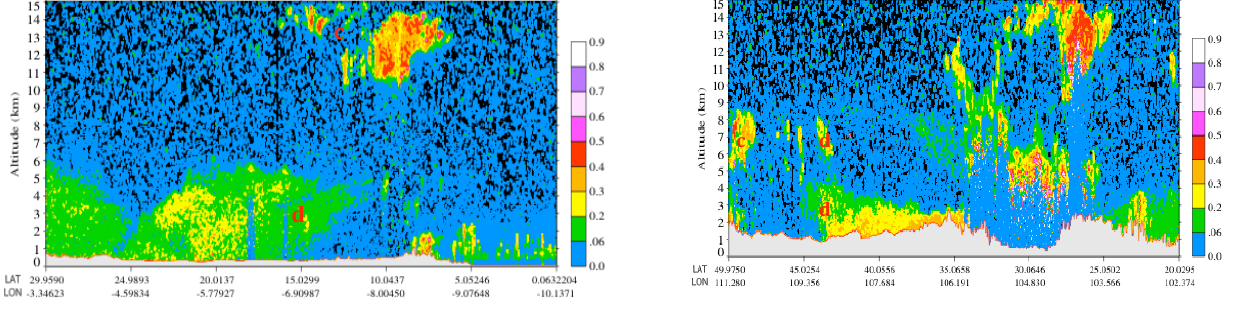
Fig. 14. The 532-nm depolarization ratio for Saharan dust on 21 July 2007. Red characters “c” and “d” represent “clouds lay- ers” and “dust plumes”, respectively.